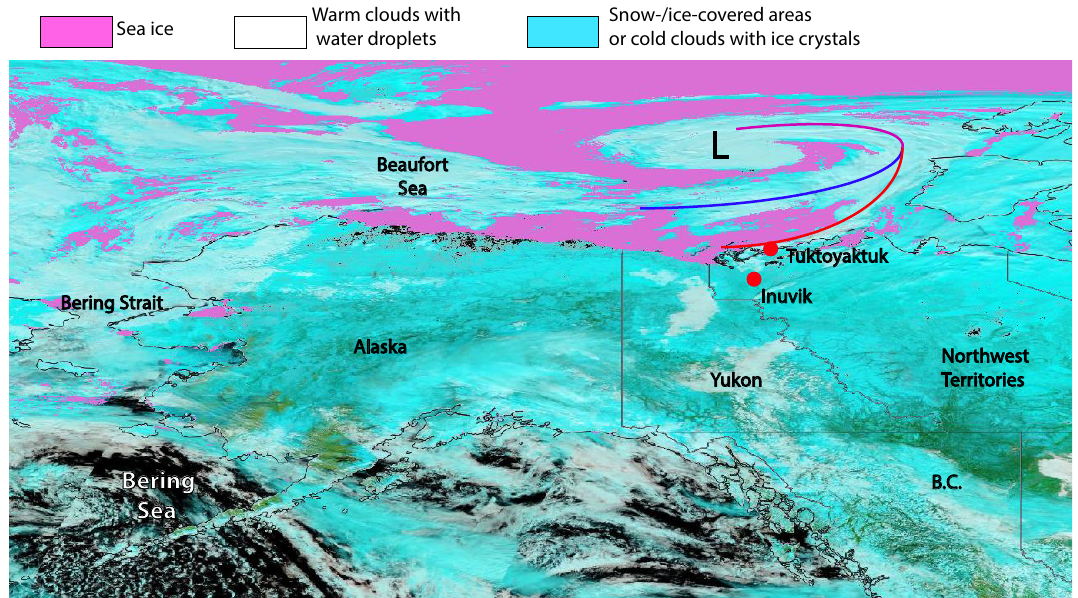
Figure 2. Map of Alaska and the north-western part of Canada showing the position of Tuktoyaktuk and Inuvik together with two addi- tional layers of the MODIS instrument (installed on TERRA, NASA). The sea ice extent layer shows the frozen ocean surface in pink. The corrected reflectance (bands 7, 2, 1) layer shows liquid water in dark blue or black. Ice on the surface or in the form of ice crys- tals in cold clouds will appear turquoise whereas small water droplets in warm clouds will appear white. A low-pressure system, which was relevant for the measurements in Tuktoyaktuk, and its corresponding fronts are marked. The map was created for 15 May 2014 us- ing NASA Worldview (https://worldview.earthdata.nasa.gov/?map=-126.907471,36.373535,-117.415283,42.815918&products=baselayers,